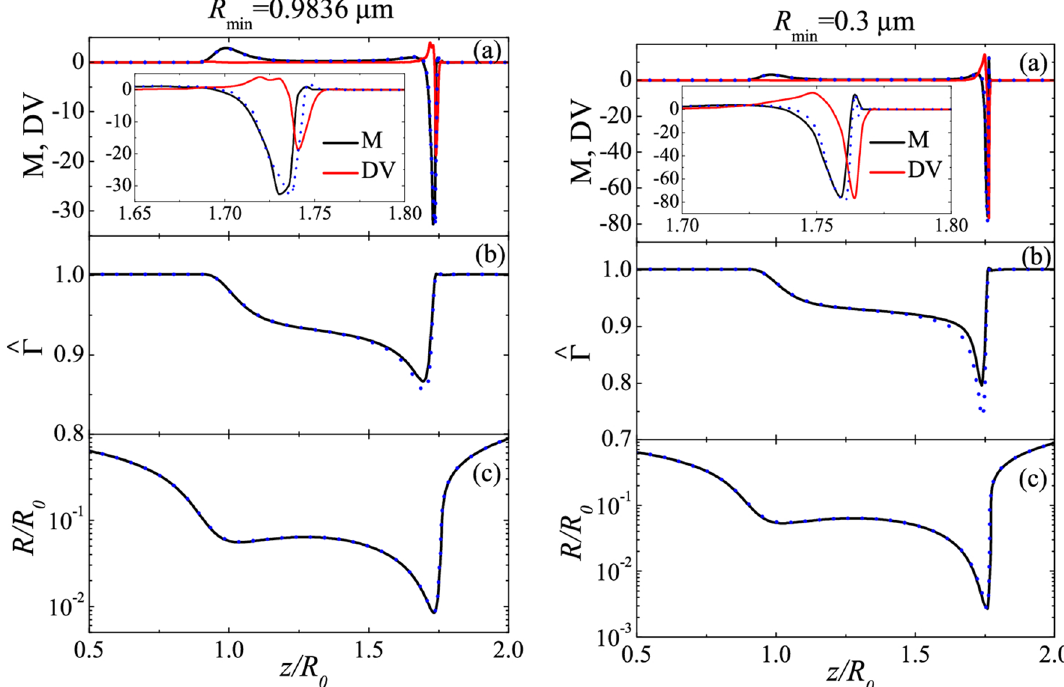
Figure 4. Axial distribution of the Marangoni stress (M) and tangential dilatational viscous stress (DV) ( a ), surfactant surface concentration ( b ), and free surface radius ( c ) for DIW+SDS 0.8cmc. The solid lines are the S ∗ 0 , µ S ∗ 3.5 × 10 − 9 Pa s m } , while the dotted lines correspond to µ S ∗ results for { µ 1 = 2 = S ∗ S ∗ 0 . The results were calculated for B = 3.396 × 10 − 3 , Oh right-hand graphs, R min = 0.3 µ m for µ 1 = µ 2 = Ŵ cmc = 1.002 , Pe S = 7.730 × 10 4 , Oh S ∗ 1 = 0 , and Oh S ∗ 2 = 4.594 × 10 − 4 (solid lines) and 0 (dotted = 0.0151, lines) (see “Methods” (cid:31)